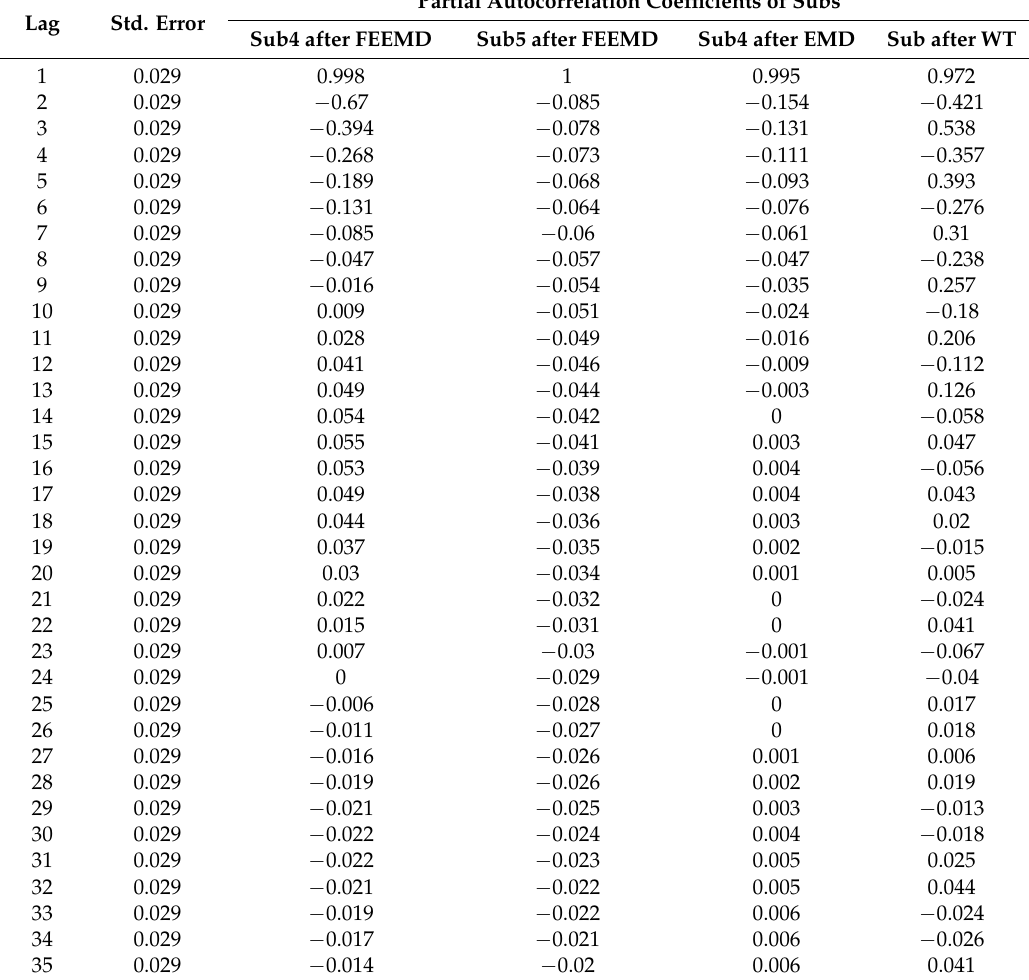
Table 7. The coefficients of different subsequences processed by partial autocorrelation function